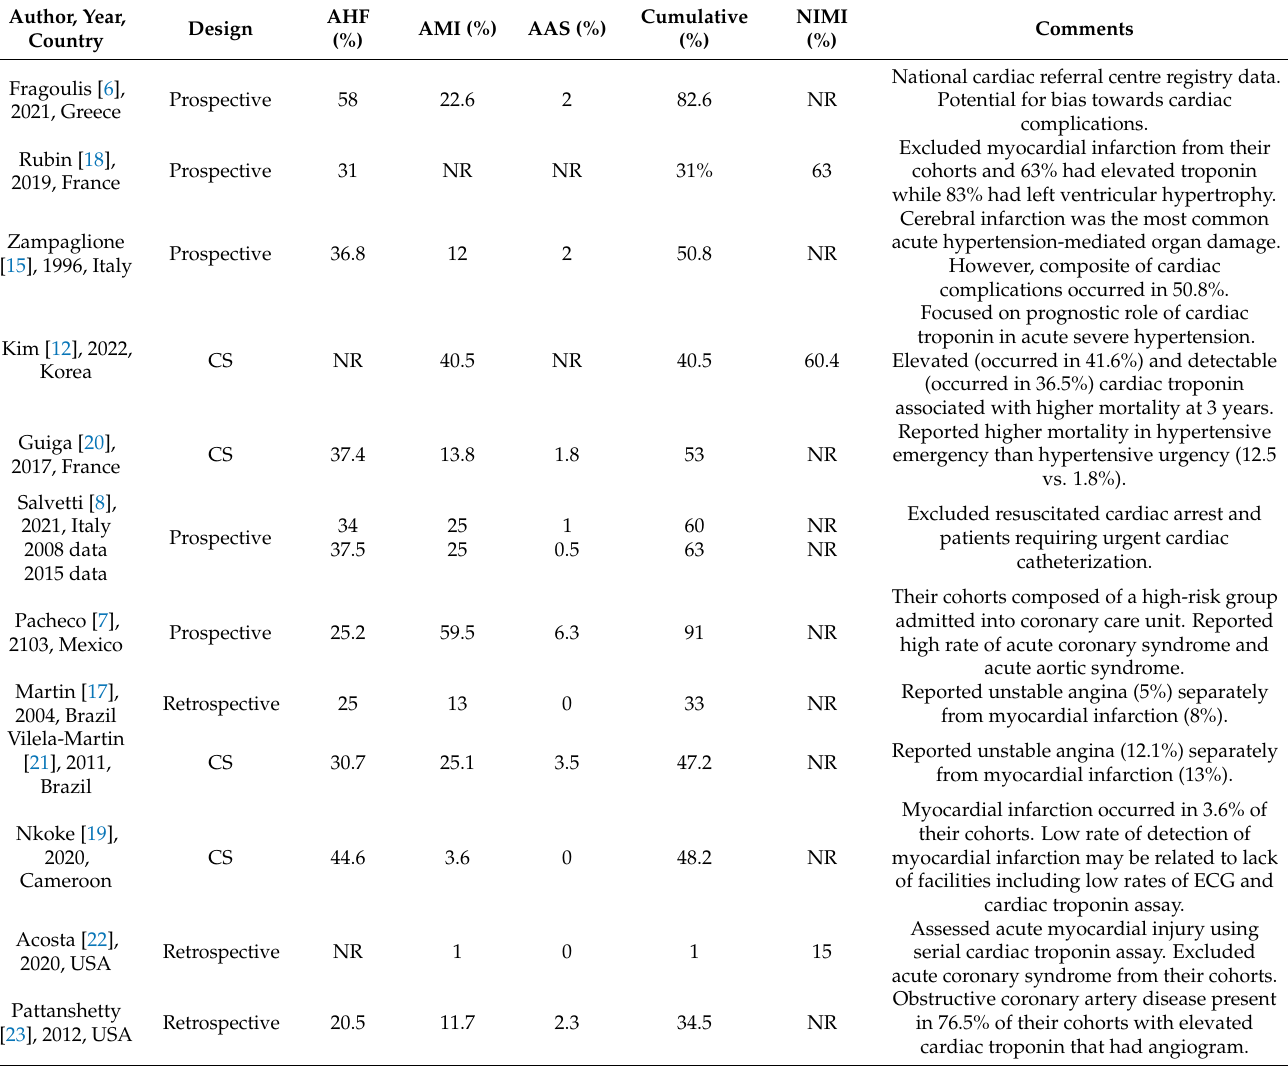
Table 1. Prevalence of cardiac acute hypertension-mediated organ damage in hypertensive emergencies.